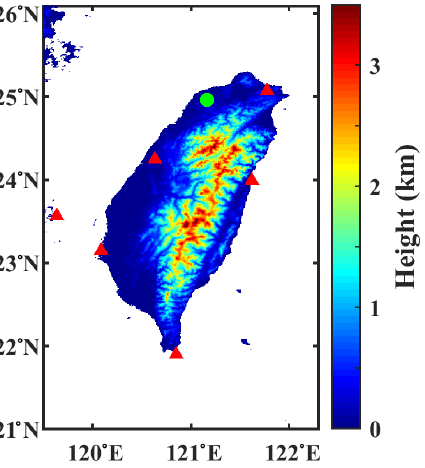
Figure 1. Map of Taiwan with disdrometer (green circle) and radar (red triangles) sites.